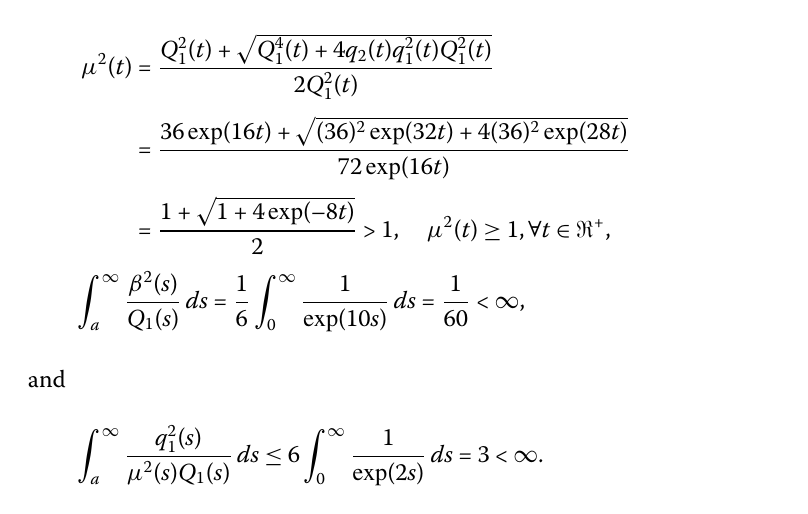
Figure 5 Trajectories of x ( t ) for Example 2 when x (0) = –1, x (0) = 1 and x (0) =